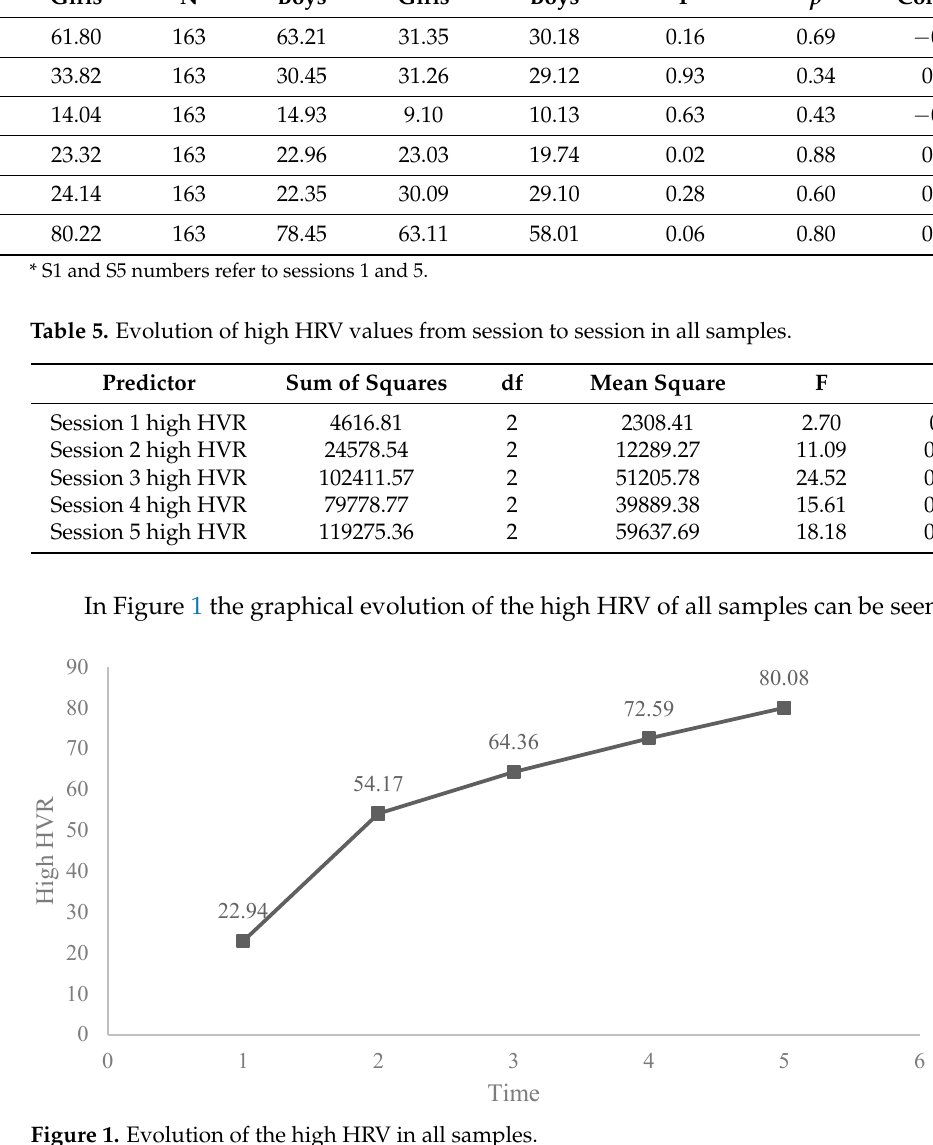
Figure 1. Evolution of the high HRV in all samples.